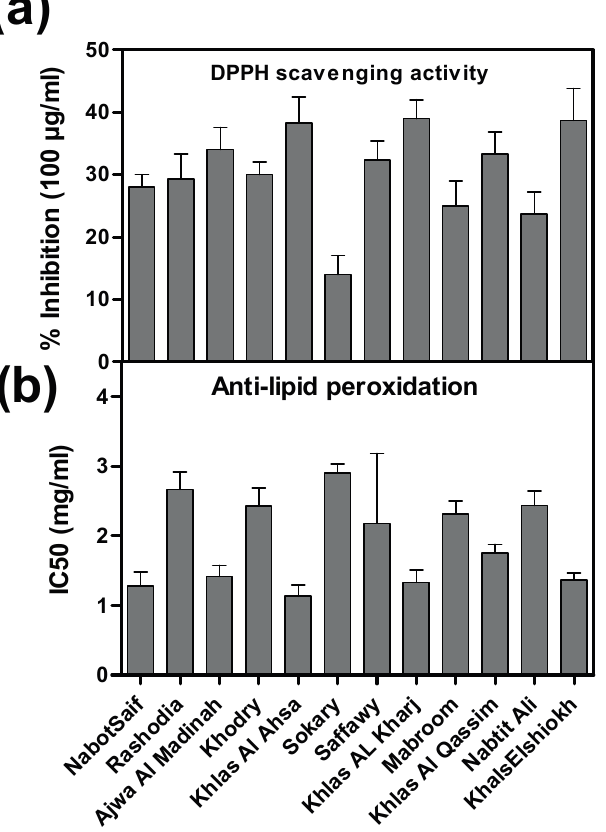
Figure 4. Antioxidant activity: DPPH scavenging activity and anti-lipid peroxidation activity of 12 Saudi date cultivars. ( a ) DPPH (1,1-diphenyl-2-picrylhydrazyl) free radical scavenging activity; ( b ) anti-lipid